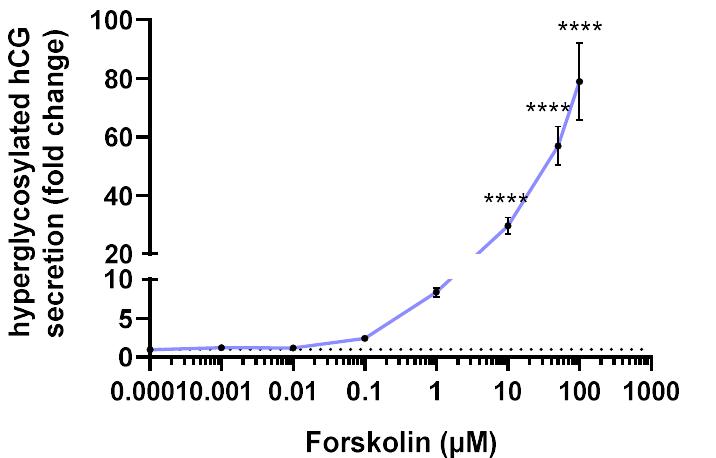
Figure 6. Hyperglycosylated hCG secretion after a 72-h incubation time with forskolin. The dotted line represents the hyperglycosylated hCG basal secretion. The significance threshold was **** p < 0.0001 compared to the culture medium.